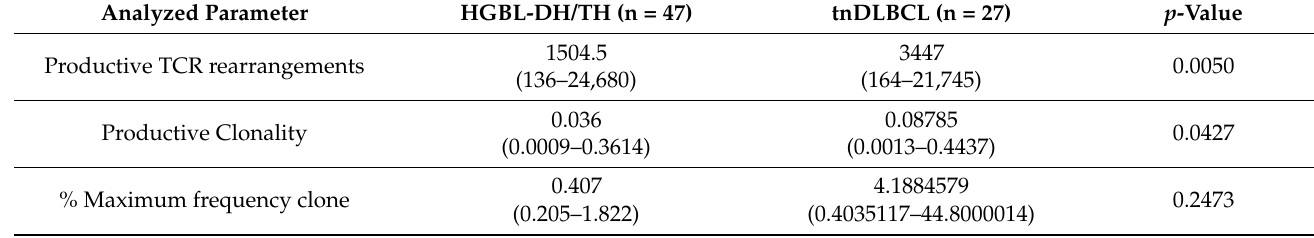
Table 4. Comparative TCR β sequencing of HGBL-DH/TH and tnDLBCL.